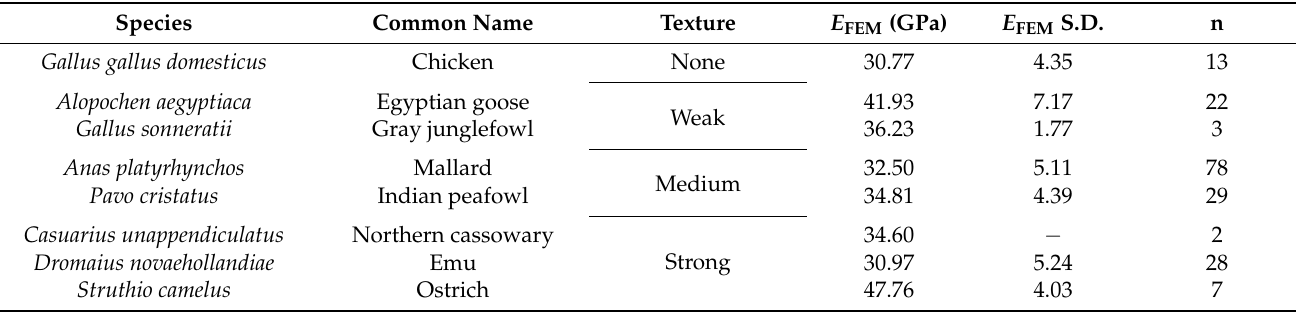
Table 2. Texture of six avian species from EBSD